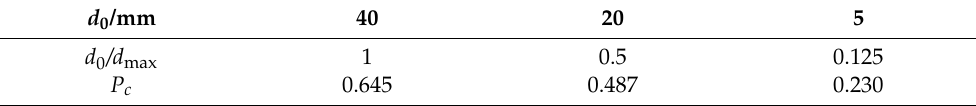
Table 1. Distribution probability of aggregate for each particle size.